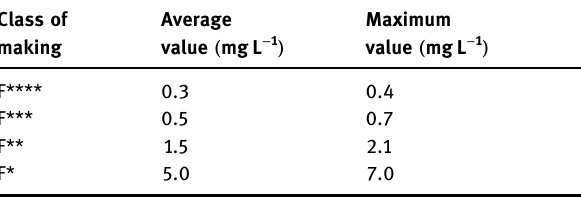
Table 18: Classi fi cation of formaldehyde emission ( JAS 2008 ) Class of Average making